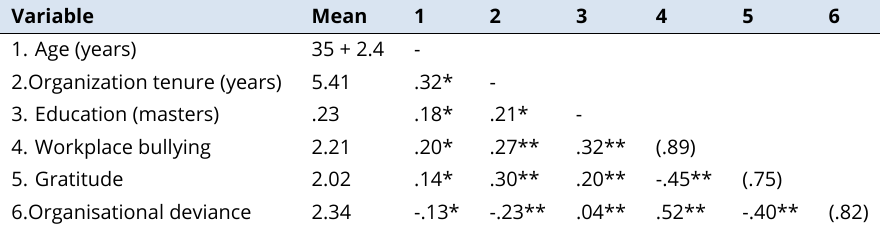
Descriptive Statistics, Internal Consistency, and Correlations among Study Variables